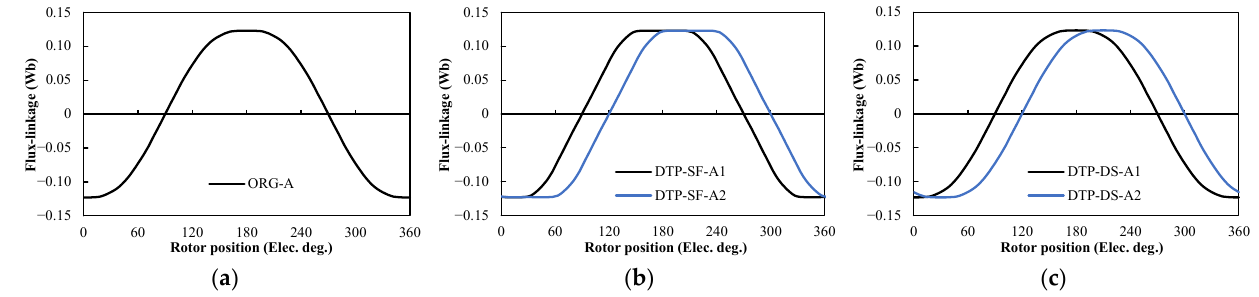
Figure 13. Phase flux-linkages of different winding configurations under OC condition: ( a ) ORG; ( b ) DTP-SF; ( c ) DTP-DS.